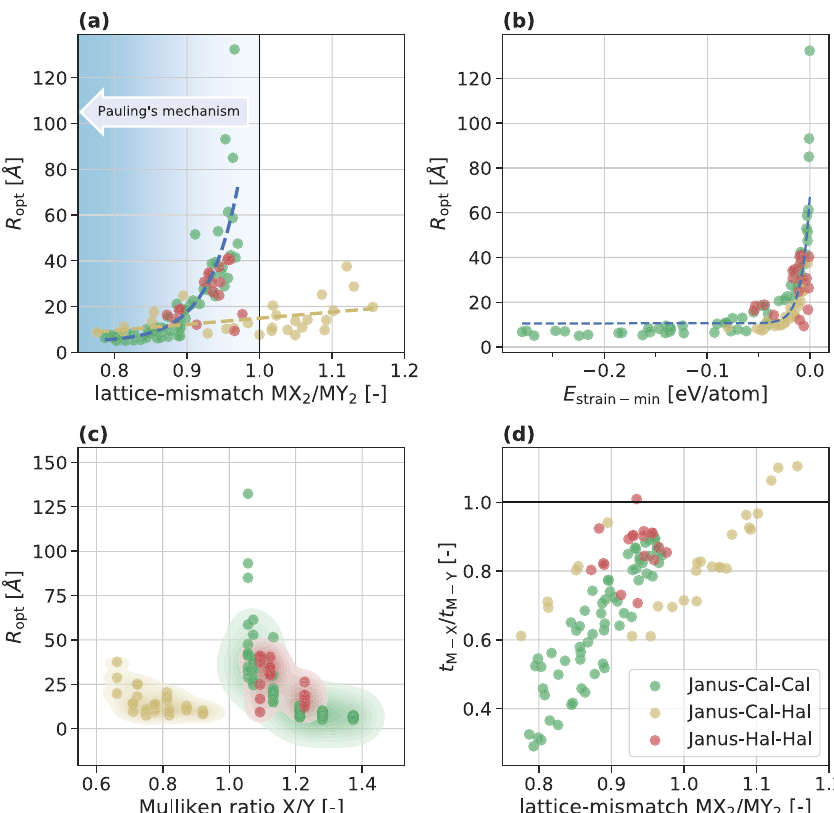
Fig. 5 Property correlations derived from nanotubes and sheets. R opt versus the lattice mismatch of the corresponding parent sheets / a MY with a being the lattice constant) ( a ), the minimum strain energy at the optimal radius ( b ) and the (lattice mismatch calculated as a MX 2 2 Mulliken ratio of the corresponding Mulliken electronegativities of outer and inner elements (Mulliken ratio X/Y) ( c ) are shown. d The ratio in layer thicknesses in the 2D Janus sheet versus the lattice-mismatch. The different colors represent the three classes of pairing the mid-layer with either two chalcogens (Janus-Cal-Cal, {O, S, Se, Te}, green), two halogens (Janus-Hal-Hal, {Br, I, Cl}, red) or a mix of chalcogens inside and halogens outside (Janus-Cal-Hal,